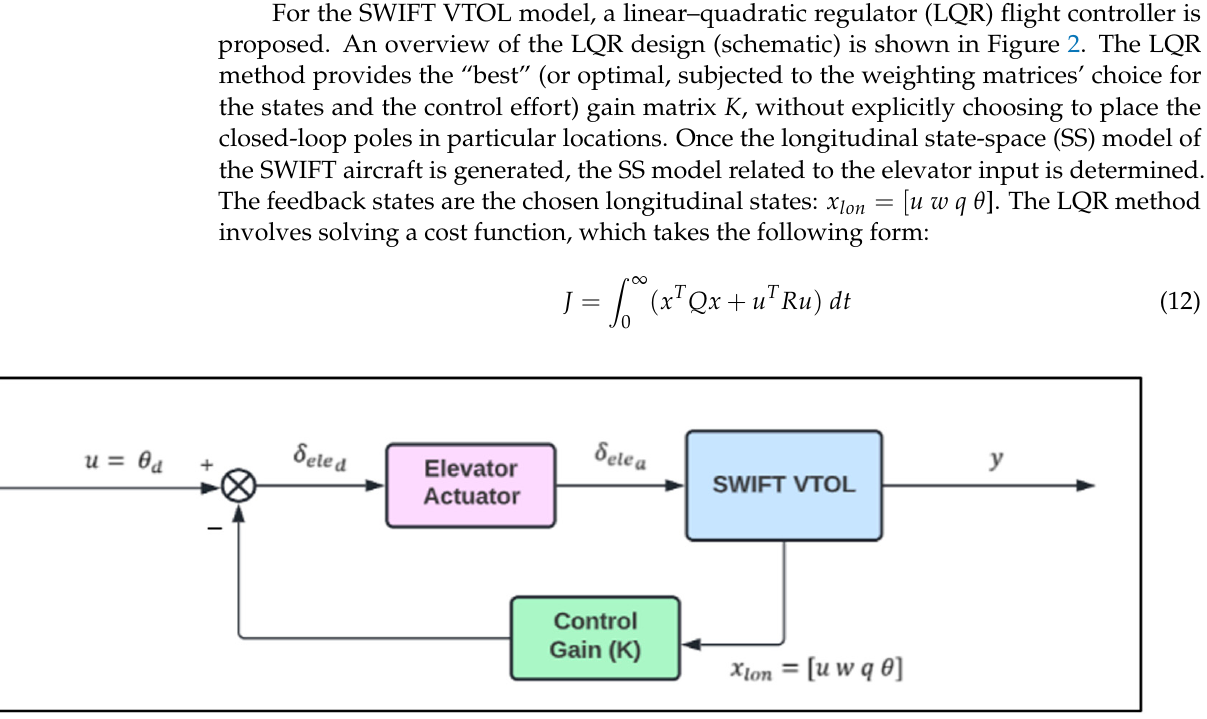
Figure 2. Schematic diagram of the proposed LQR controller for the SWIFT VTOL model.